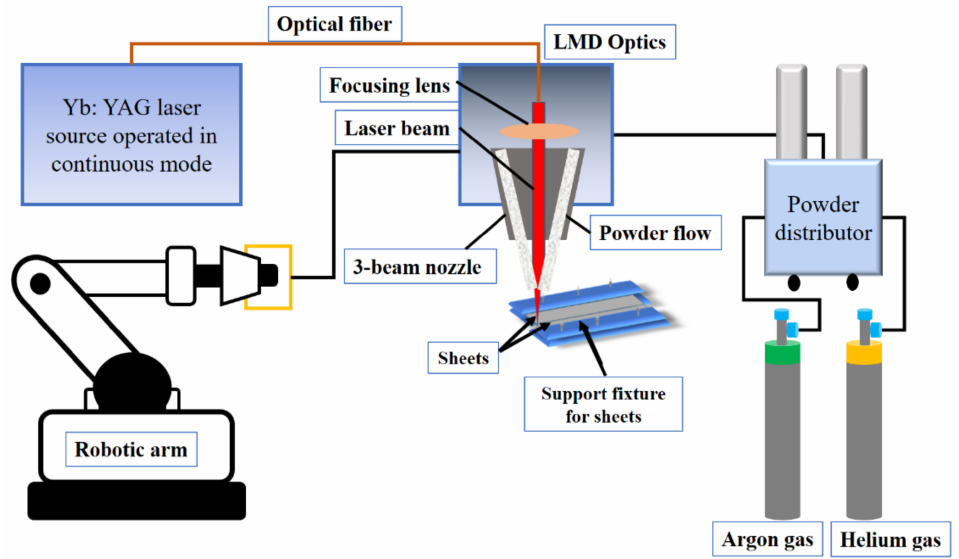
Figure 1. Laser welding via LMD